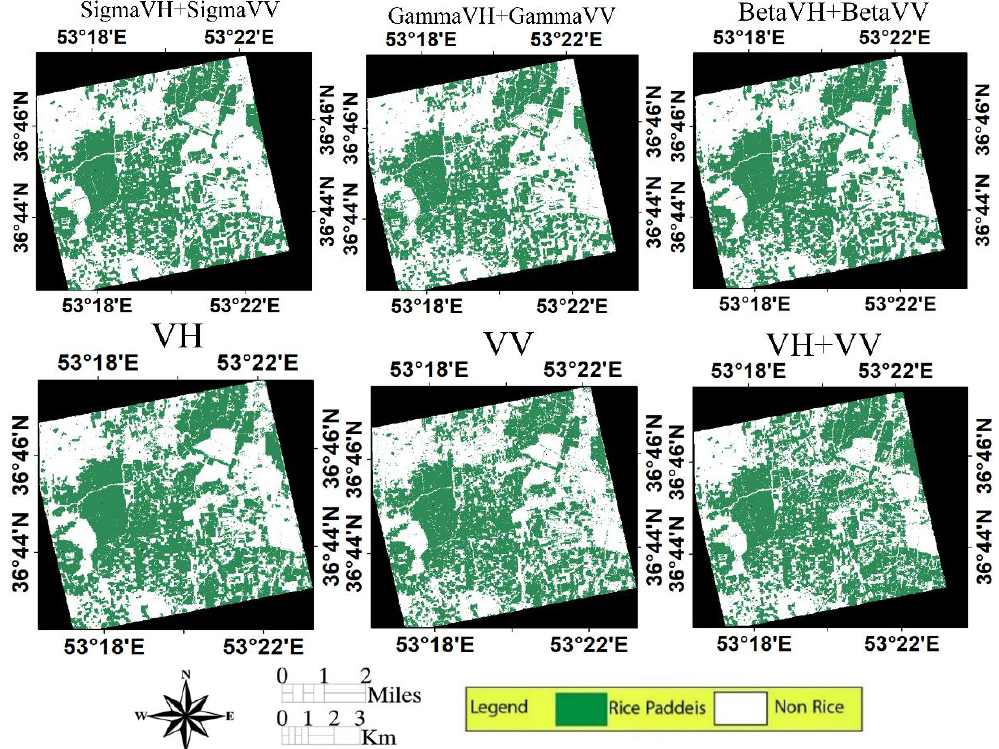
Figure 6. Rice crop map derived from multiple time series of Sentinel-1